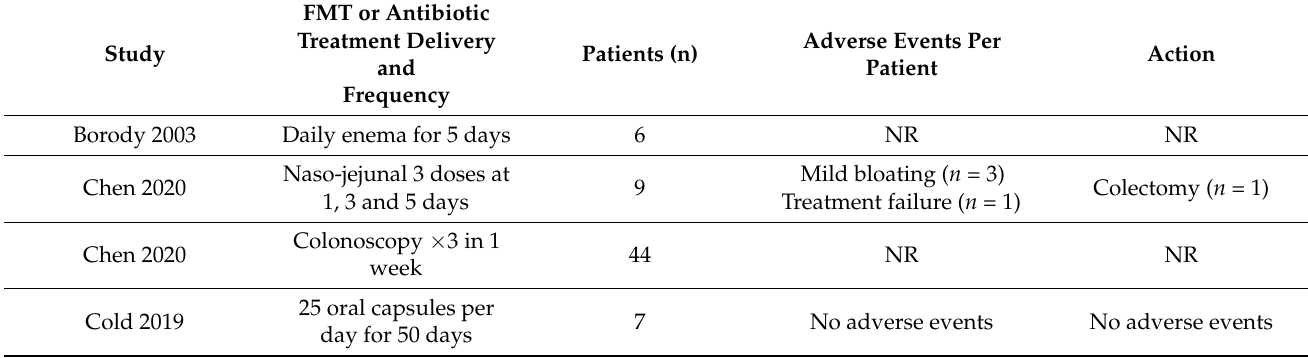
Table 5. Adverse events and interventions reported for included